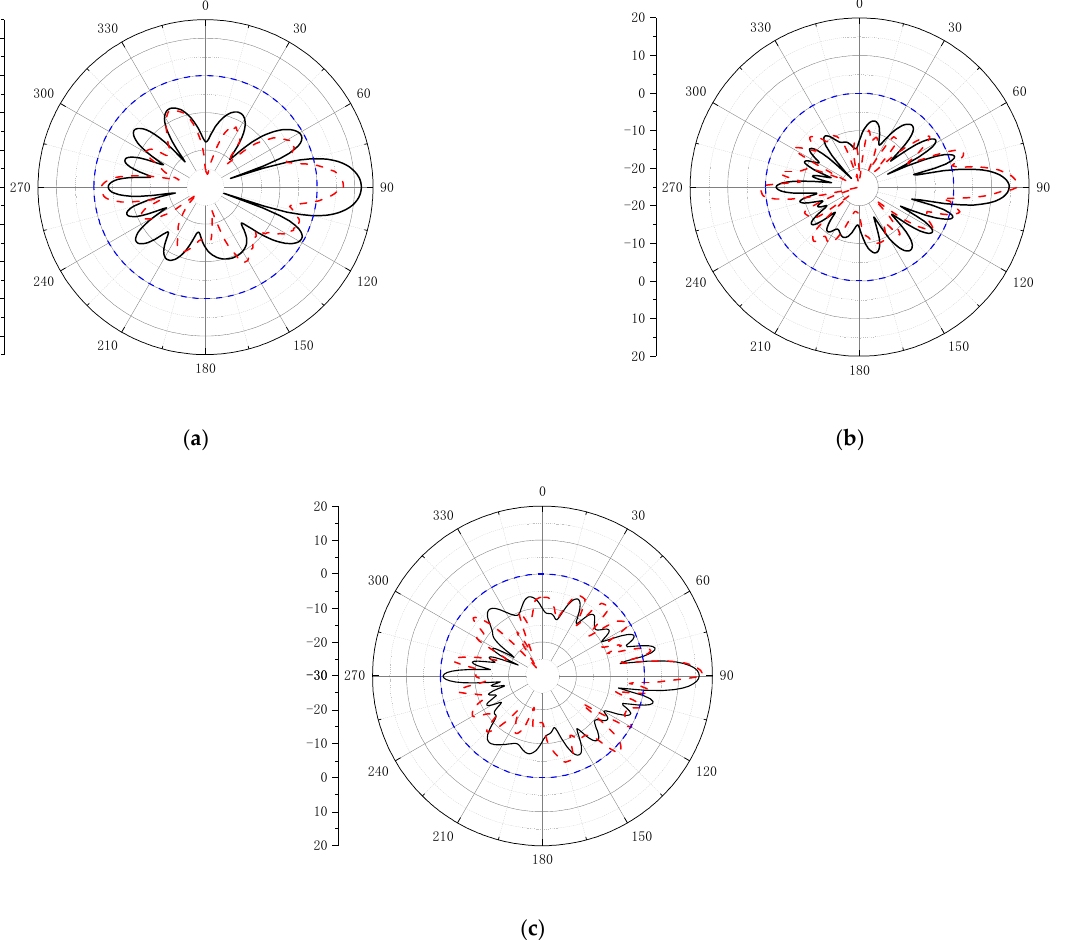
Figure 8. E-plane pattern of Vivaldi 8-element array with structure at ( a ) 2 GHz; ( b ) 3 GHz; and ( c ) 4 GHz.